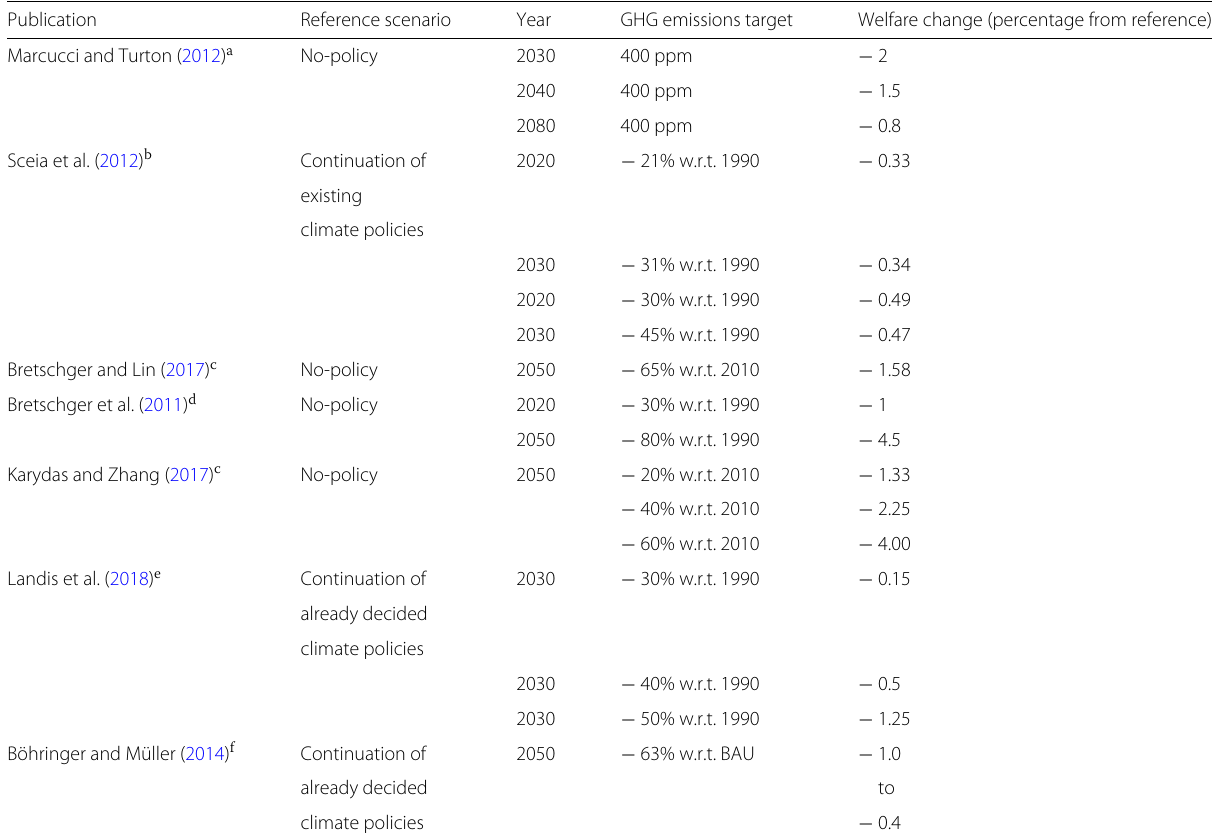
Table 1 Welfare results of different studies on Swiss climate